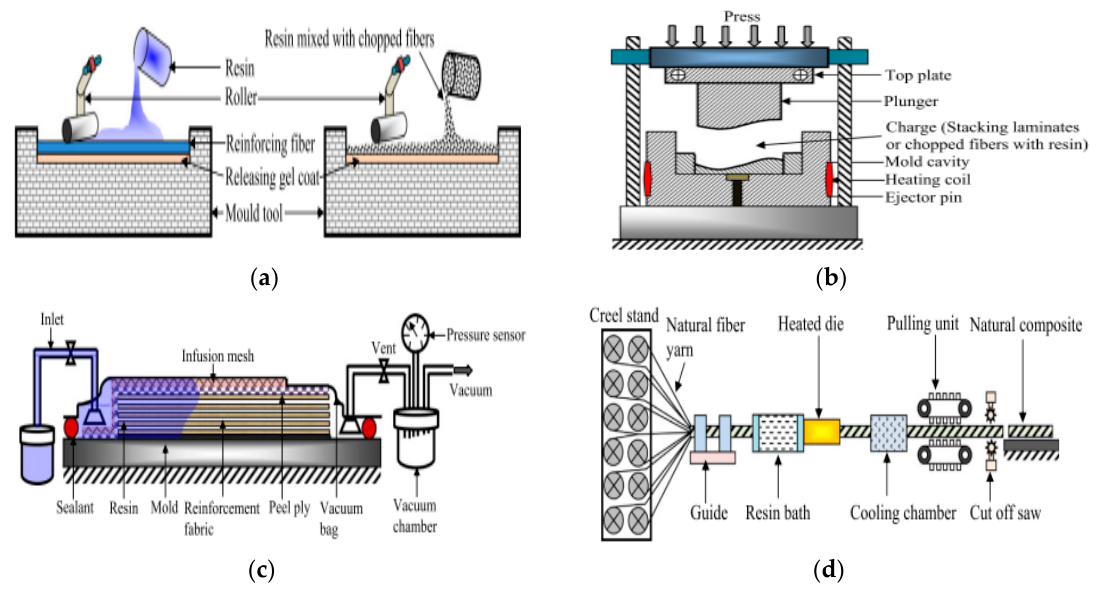
Figure 1. Epoxy manufacturing techniques: ( a ) Hand lay-up, ( b ) compression molding, ( c ) vacuum-assisted resin transfer molding, and ( d ) pultrusion [16] (Reprinted/adapted with permission from Elsevier Ref.5457180037607).